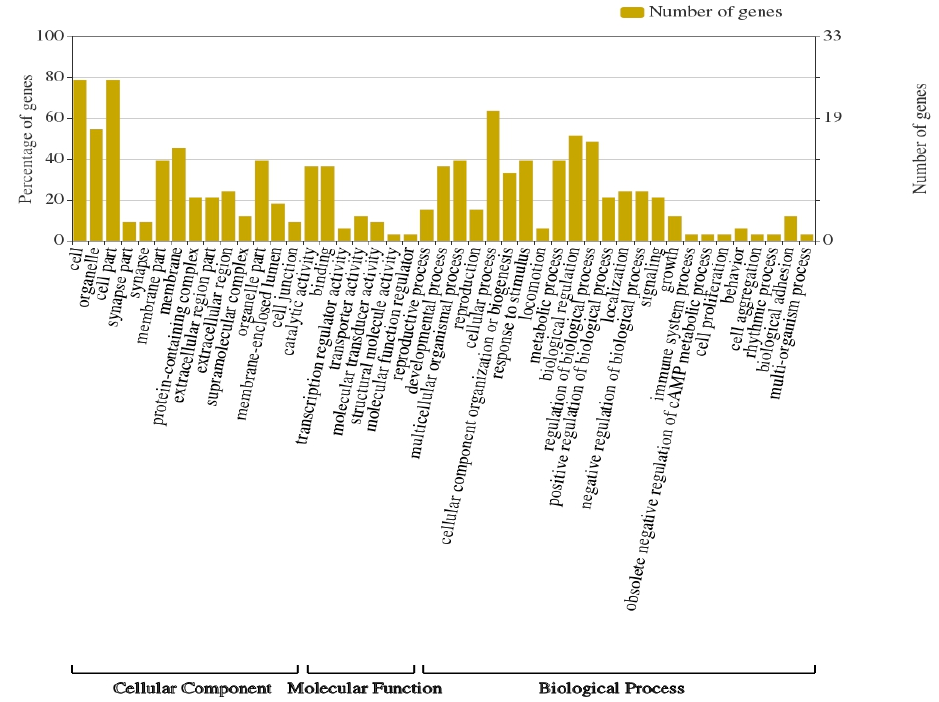
Figure 4. Gene ontology categories identified in genes with significant SNPs.